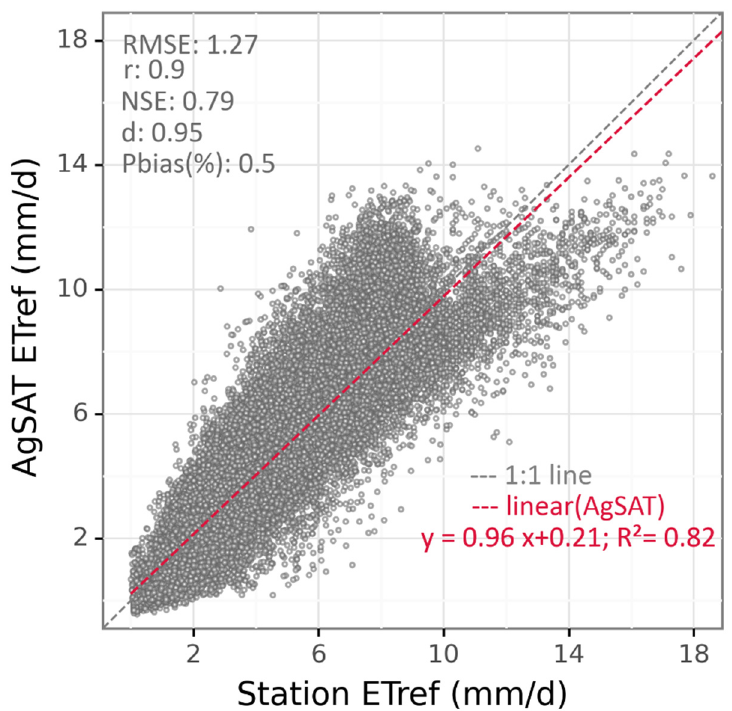
Figure 4. AgSAT reference evapotranspiration comparison with in situ measurements of reference evapotranspiration from 18 weather stations.